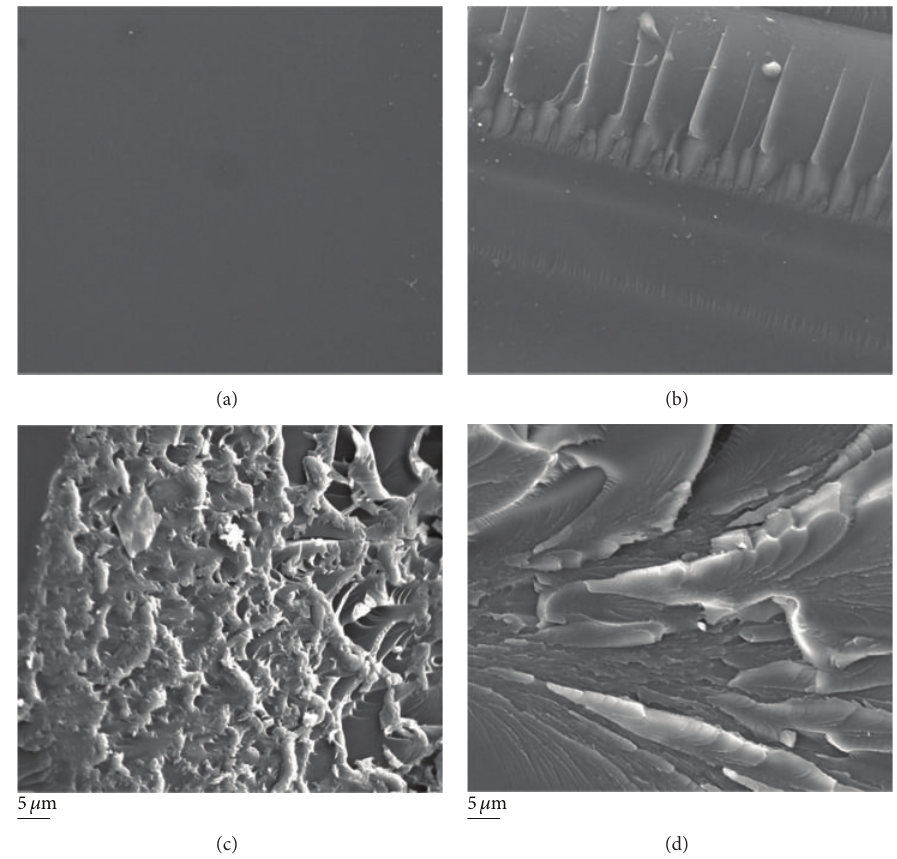
Figure 10: Impact surfaces of UFUR/TMBPDE composite resins ((a) TMBPDE-0; (b) TMBPDE-5; (c) TMBPDE-15; (d) TMBPDE-30).